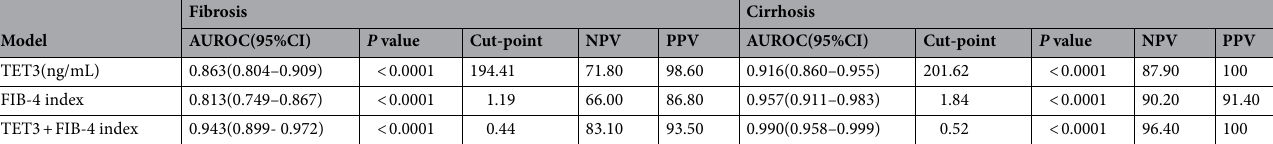
Table 4. Diagnostic test characteristic of TET3, FIB-4 index and multivariable model in detecting liver fibrosis and cirrhosis. NPV: Cut-point was derived from the Youden’s index, NPV: Negative predictive value, PPV: Positive predictive